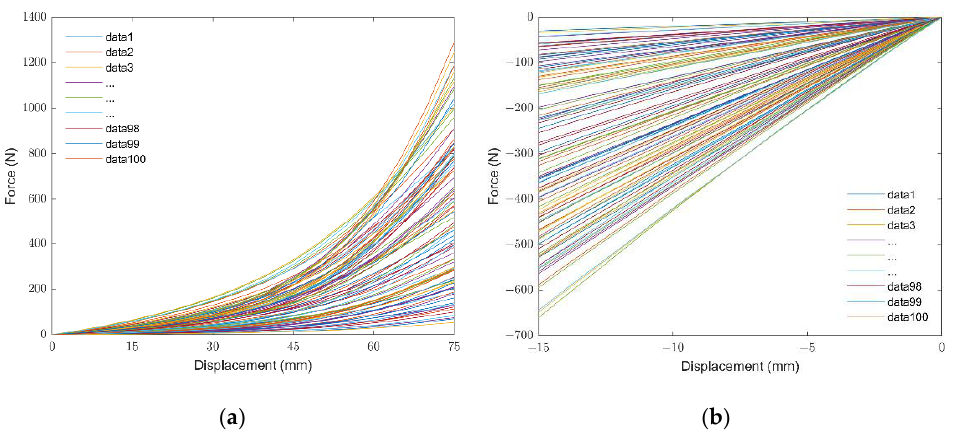
Figure 9. Virtual data sets: ( a ) Oring tension test and ( b ) Oring compression test.